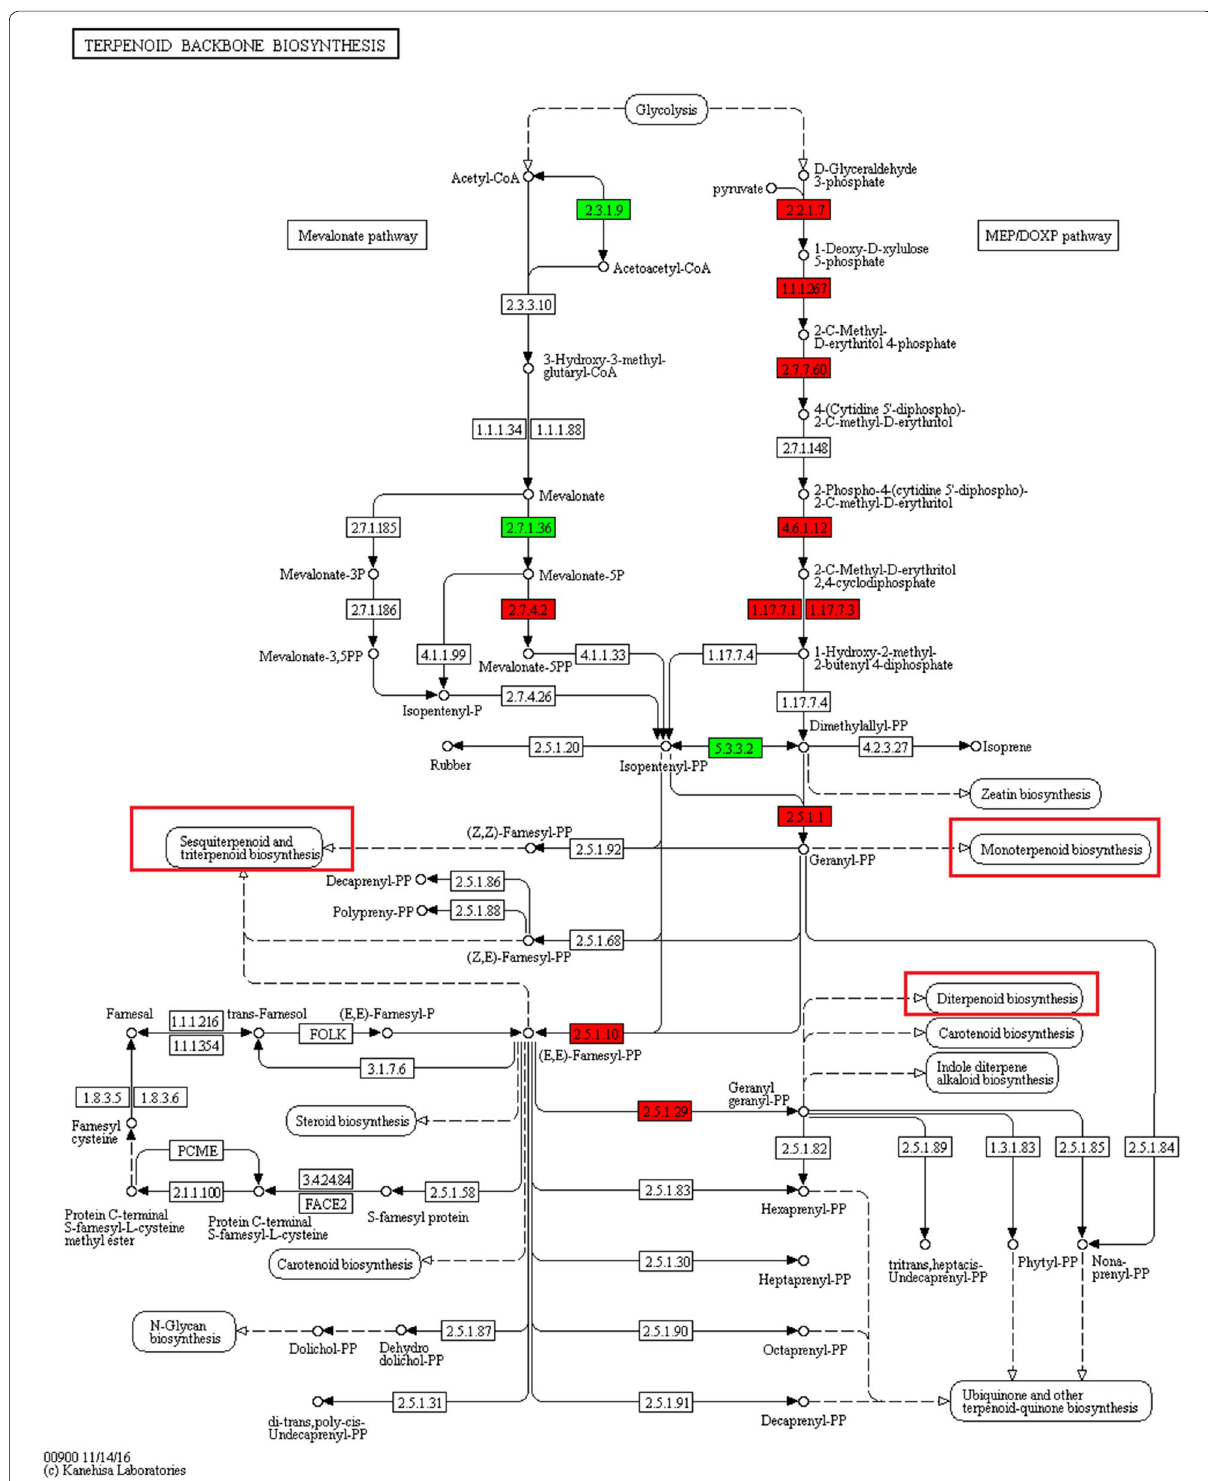
Fig. 4 Differentially expressed genes (DEGs) involved in the “terpenoid backbone biosynthesis” pathway of ginger. The red columns indicate genes expressed at a significantly high level in fibrous roots. The green columns indicate genes expressed at a significantly high level in rhizomes. The red boxes indicate the biosynthesis of the major compounds found in ginger volatile oil. This color-coded map of DEGs corresponds to map00900 in the KEGG database